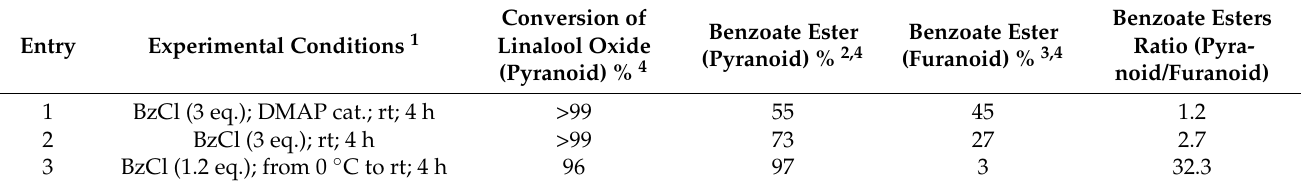
1 Reaction conditions: Each experiment was performed using 10 mMol of a mixture of linalool oxide isomers (81:19 ratio of fura- noid/pyranoid isomers). The alcohols mixture, in dry CH 2 Cl 2 (4 mL) was treated under stirring with 1 mL of pyridine followed by the addition of BzCl, according to the experimental conditions indicated in the table. The molar equivalents of BzCl were calculated in relation to the starting amount of pyranoid linalool oxide. 2 Percentage of the pyranoid benzoate esters in relation to the sum of all the linalool oxide benzoate ester isomers. 3 Percentage of the furanoid benzoate esters in relation to the sum of all the linalool oxide benzoate ester isomers. 4 Compounds concentrations were determined by GC-MS